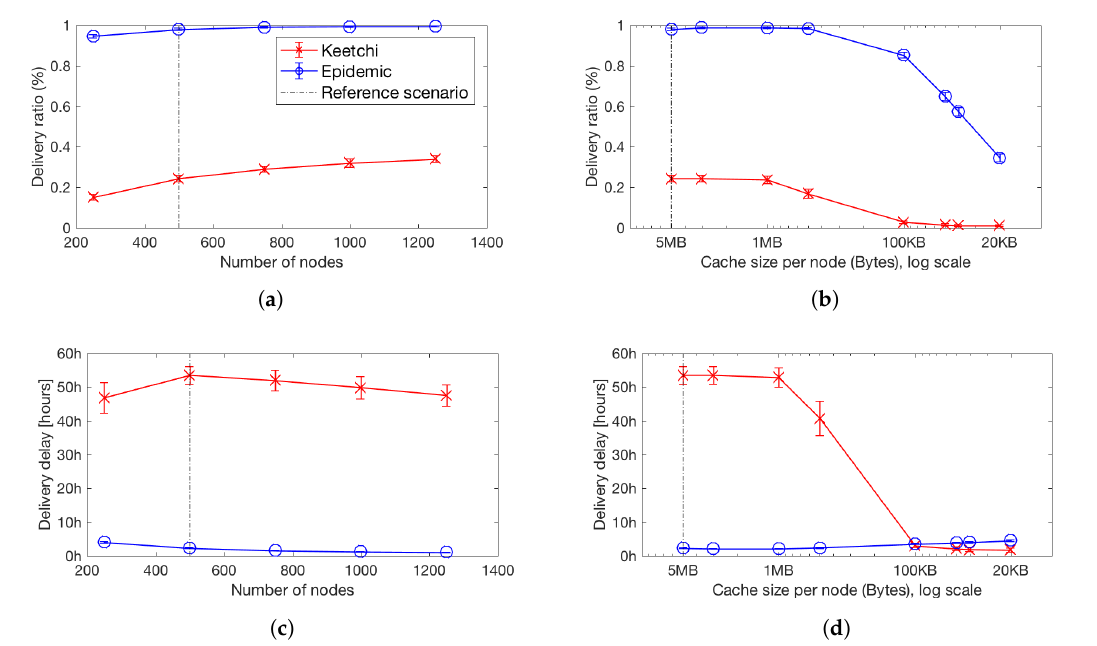
Figure 9. Performance comparison for unpopular data items. Mean and 99% confidence intervals of: ( a ) delivery ratio, unpopular messages, more nodes in the network; ( b ) delivery ratio, unpopular messages with decreasing cache size; ( c ) delivery delay, unpopular messages, more nodes in the network; and ( d ) delivery delay, unpopular messages with decreasing cache